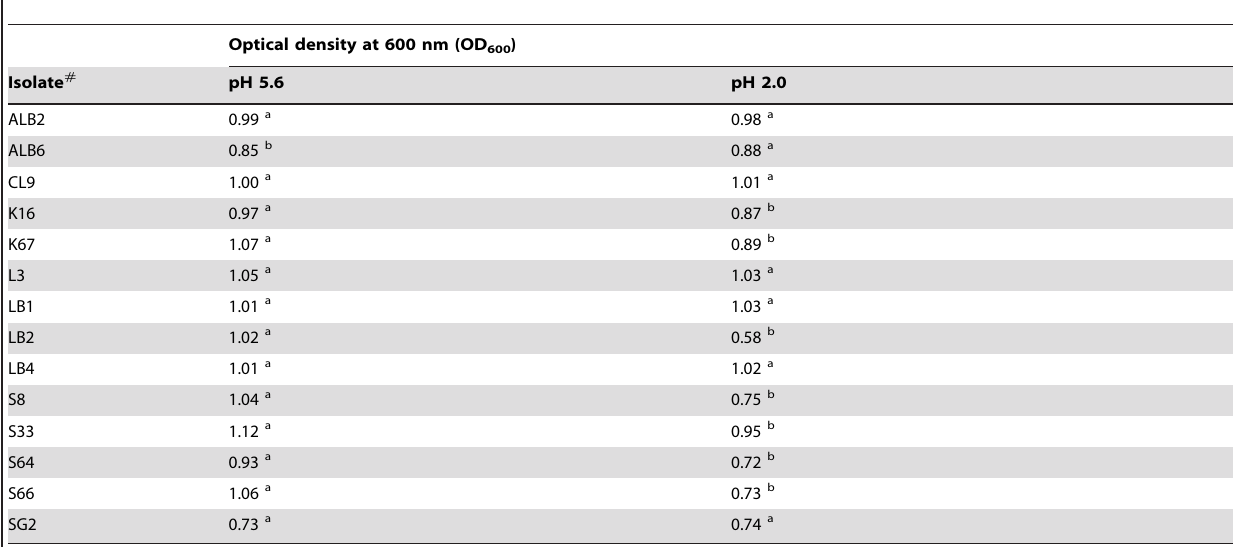
Table 1. Growth (OD 600 ) of selected lactic acid-producing bacterial isolateswith or without pretreatment of low pH * .